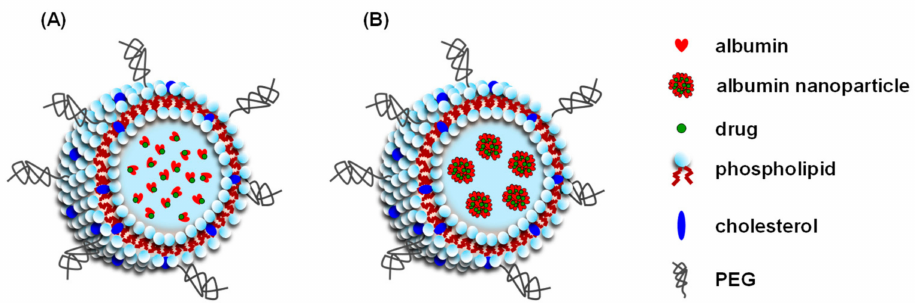
Figure 3. Schematic structure of the albumin-encapsulated liposome-encapsulated albumin-drug complex ( A ) and drug-loaded albumin nanoparticle ( B ).